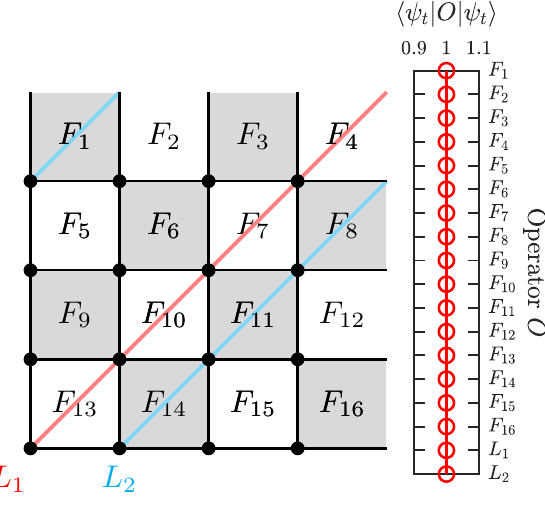
can be targeted using VQCS p = L / 2 + 1 p = L / 2 cannot tar- p < L / 2